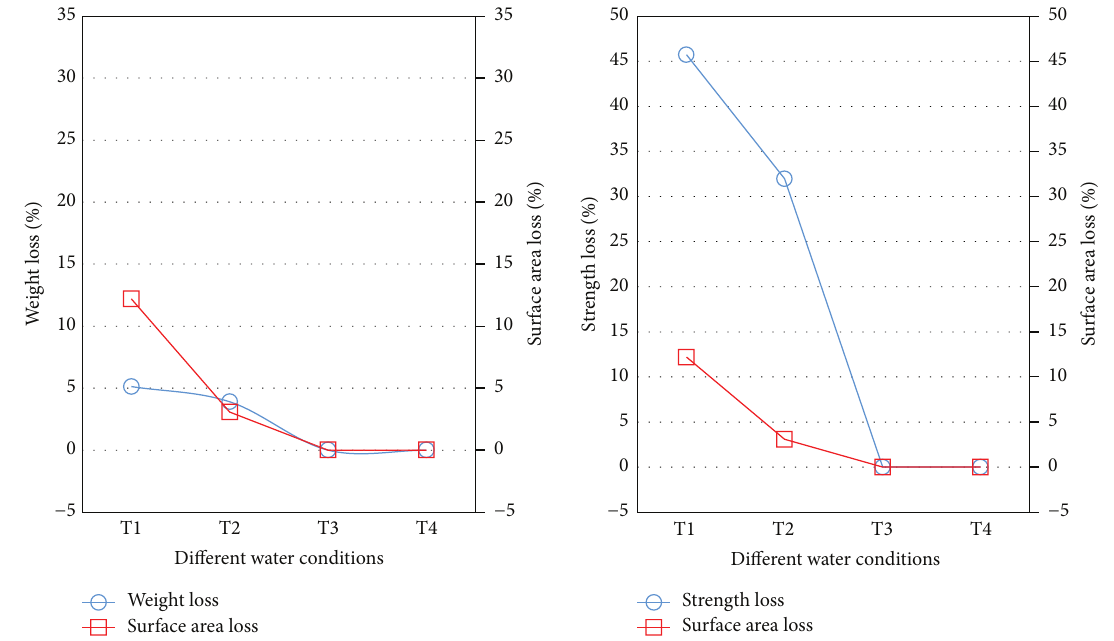
Figure 11: Comparison of surface area loss with weight loss and strength loss at 90